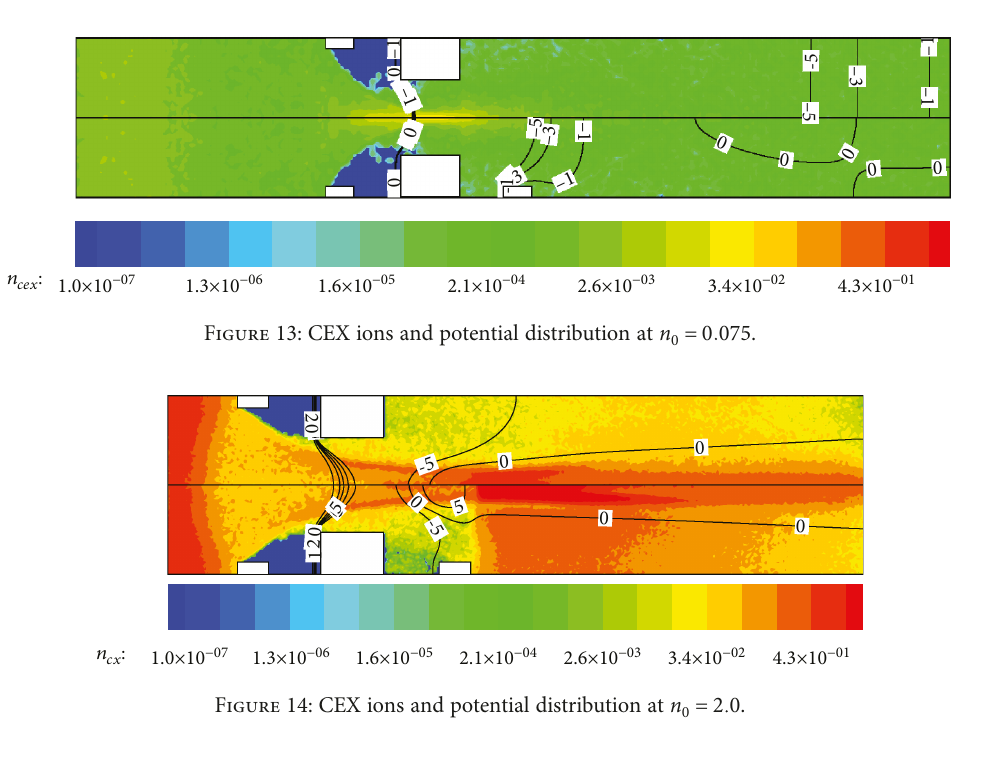
Figure 14: CEX ions and potential distribution at n